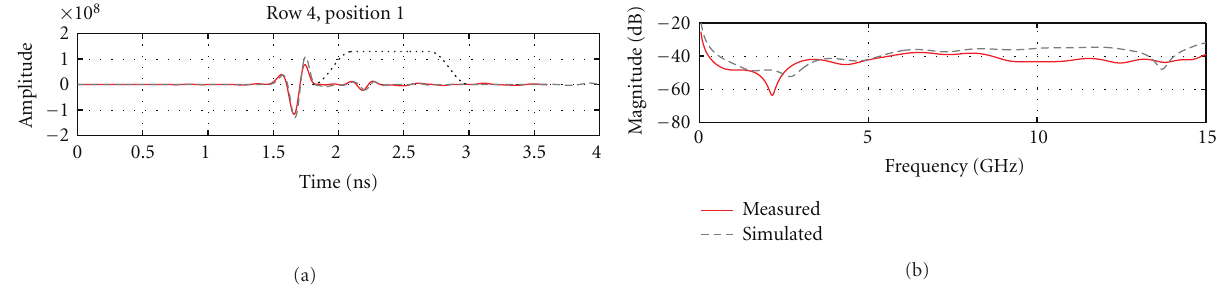
Figure 13: (a) Calibrated reflection from the breast model recorded by the antenna situated the closest to the inclusion. Dotted line shows the extent of the Tukey window that is used to isolate the later-time response. (b) The frequency response of the later-time component of the signals.